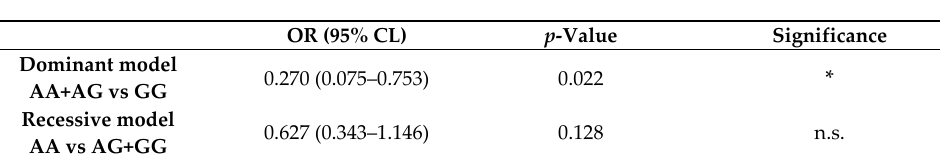
Figure 1. Genotypic and allelic frequencies of the Interferon gamma ( IFNG ) rs1861494 single nucleotide polymorphism (SNP) in healthy donors (HD) and tuberculosis patients (TB) populations in Argentina. ( A ) Pie chart representing the genotypic and allelic distribution of the IFNG rs1861494 SNP in both populations. The number of individuals of each population and the frequencies (in parentheses) are detailed. p -values were calculated by the Χ 2 test of homogeneity. Both populations were in Hardy-Weinberg (HW) equilibrium. ( B ) Odds ratios (OR) calculation was used to quantify the association between tuberculosis and the different genotypes. ( C ) Dominant and recessive genetic models for the association between the ra1861494 SNP and TB. Odds Ratio were calculated by logistic regression after adjusting for confounding variables (age/ethnicity/sex).